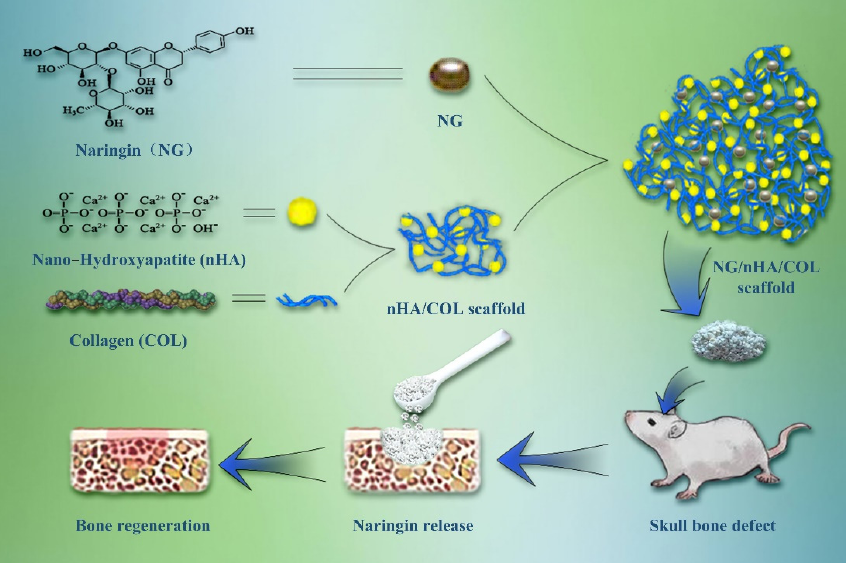
Figure 1. Schematic illustration of NG/nHA/COL scaffold construction and the pipeline of NG/nHA/COL scaffold applied for bone regeneration.